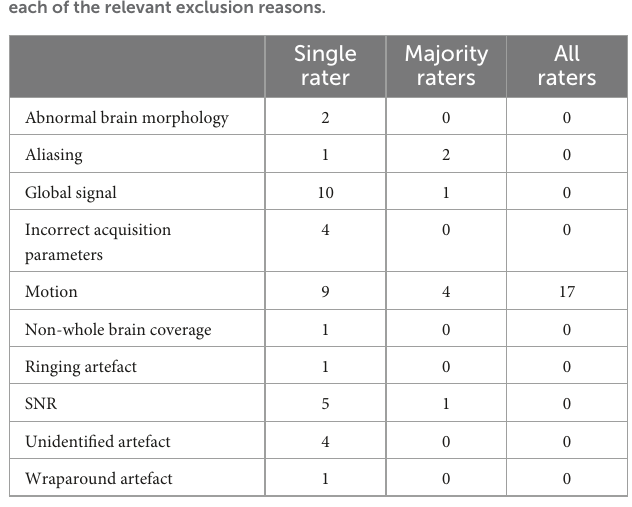
alpha to 0.694 [95% bootstrap confidence intervals (0.559,